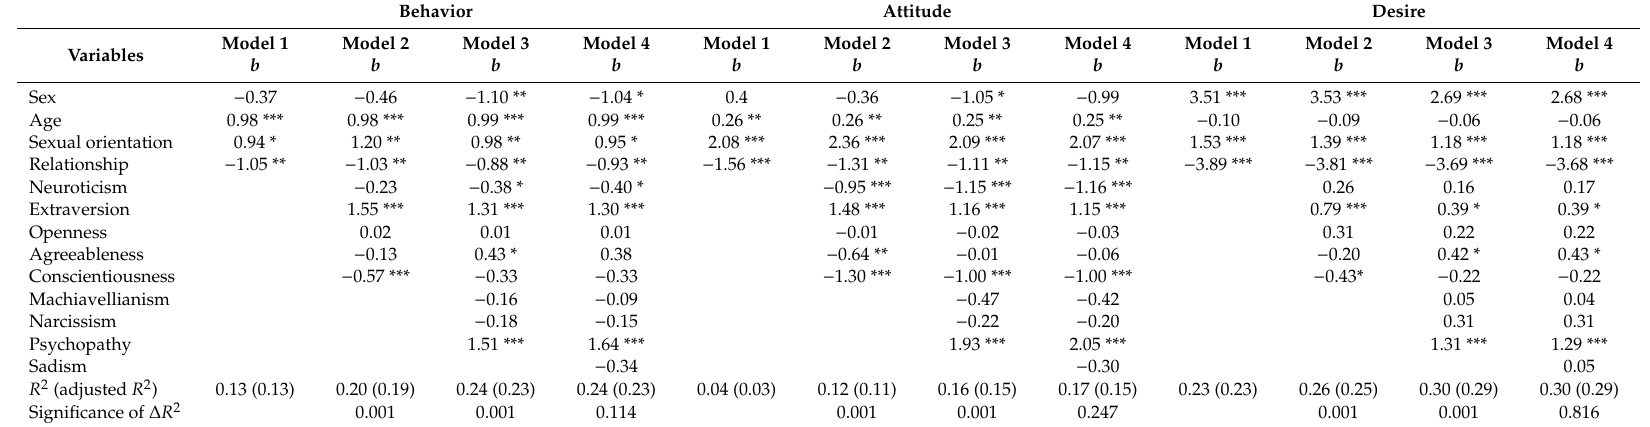
Table 2. Hierarchical regression analysis of three dimensions of